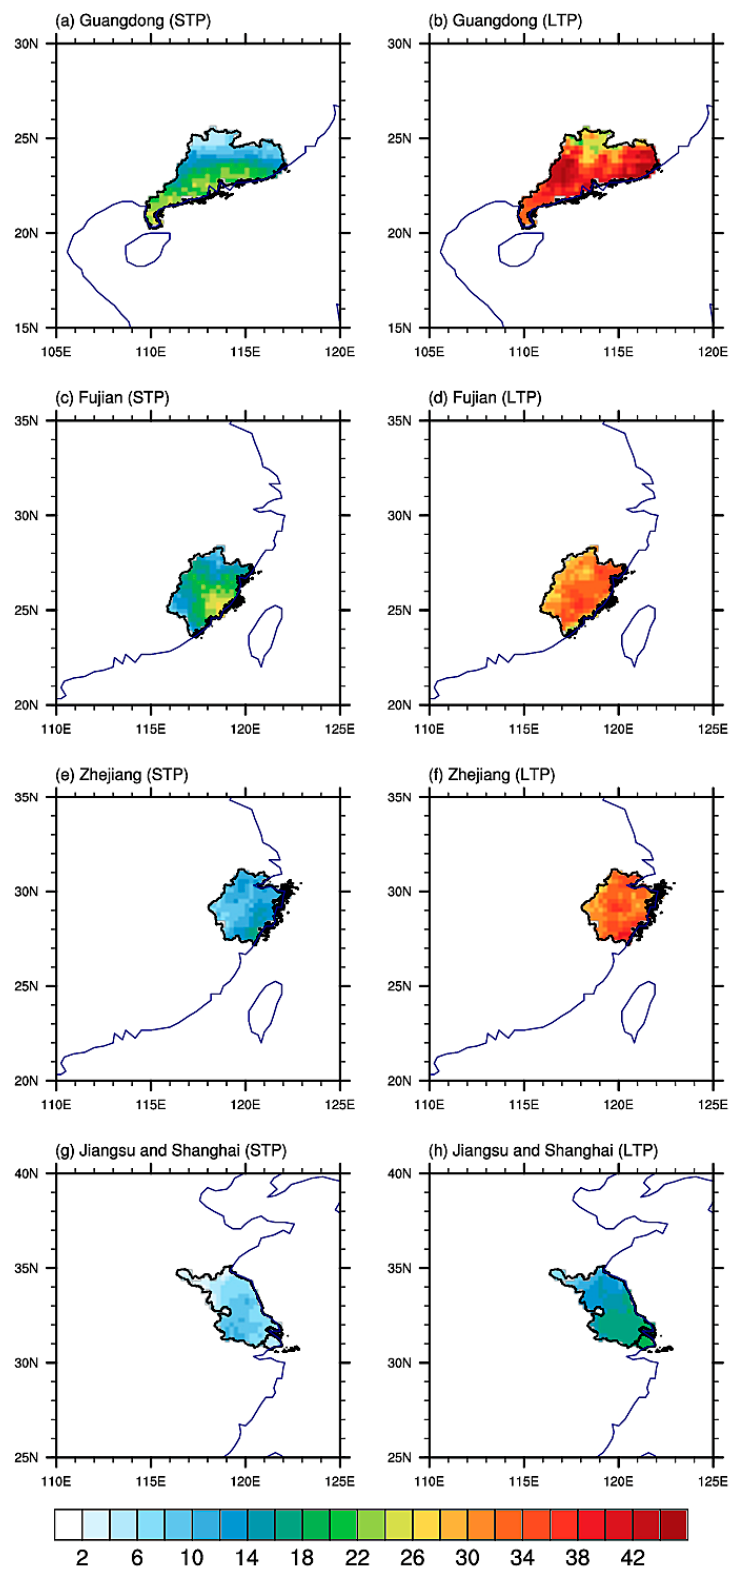
Figure 2. Impact frequency of TCs that caused direct economic loss. Units are total number of TC impact occurrences in the period 1999–2018. For four regions of mainland China: Guangdong, Fujian, Zhejiang, and Jiangsu and Shanghai (from top to bottom ). Impact frequency based on STP ( a , c , e , g left column ) and LTP ( b , d , f , h right column ) are shown.